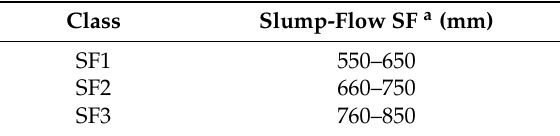
Table 5. Consistency class according to slump-flow test (slump-flow test) [47].